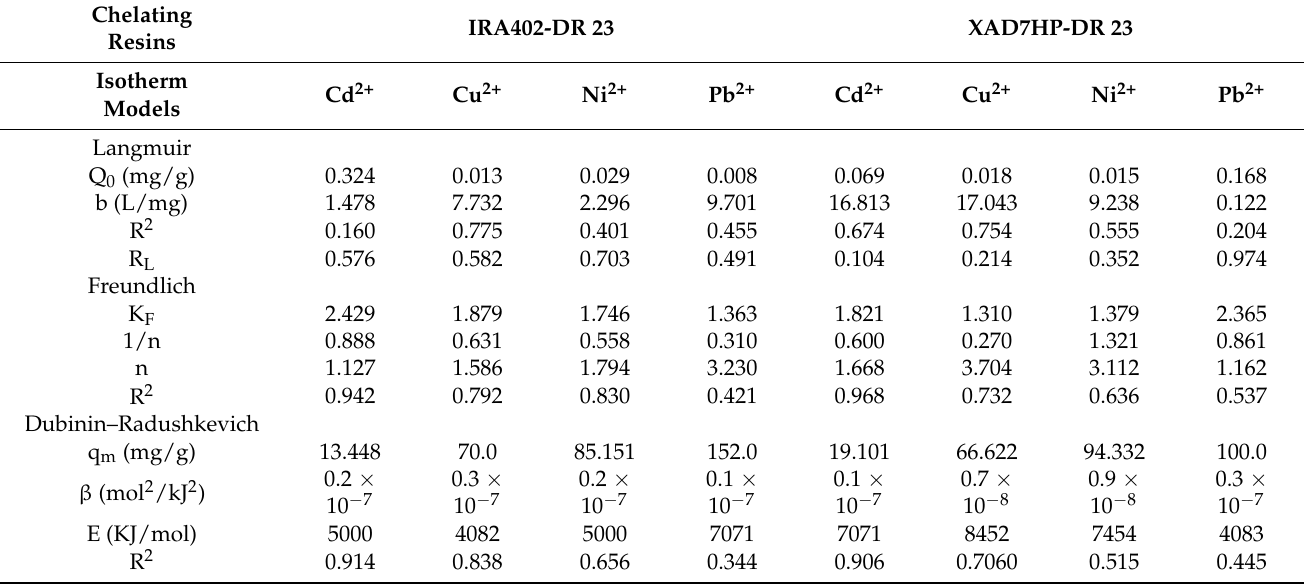
Table 3. Langmuir, Freundlich and Dubinin Radushkevich isotherm constants regarding M 2+ adsorp- tion on chelated